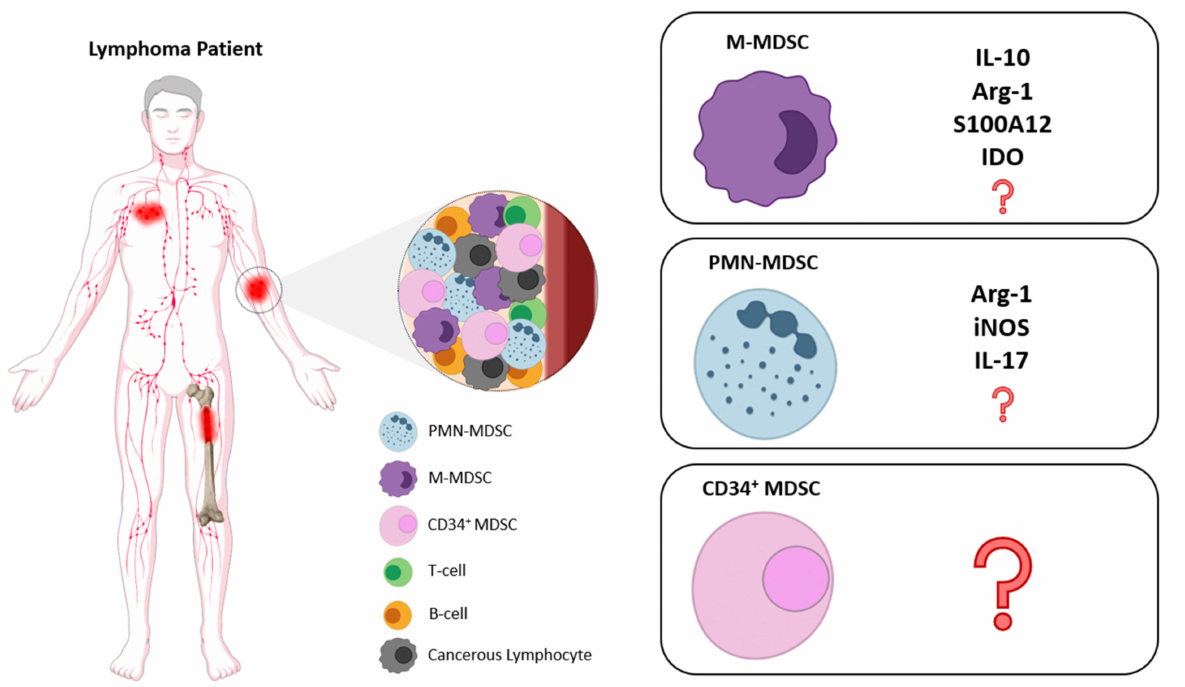
Figure 1. MDSC subsets and suppression mechanisms in lymphoid malignancies. The main immune cell subsets and malignant cells that circulate in the blood of lymphoma patients are illustrated ( left side ). The MDSC subsets and the respective mechanisms that have been described for MDSC-mediated suppression of anti-tumor immunity in different types of lymphomas are shown ( right side ). Question marks indicate unknown mechanisms via which MDSCs may exert their function in lymphoma malignancies. MDSCs: Myeloid-derived suppressor cells; PMN-MDSCs: polymorphonuclear MDSCs; M-MDSCs: monocytic-MDSCs; IL-10: Interleukin-10; Arg-1: Arginase 1; S100A12: S100 calcium-binding protein A12; IDO: indoleamine 2,3-dioxygenase; iNOS: inducible Nitric Oxide Synthase; IL-17: